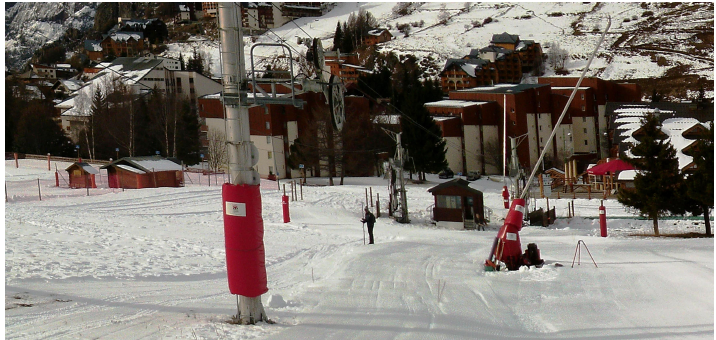
Figure 1. The Coolidge ski slope conditions on 4 December 2015, the day before the resort opened. Edges with unprepared areas and obstacles (trees, lift infrastructures, snowgun) of the ski slope can clearly be seen.